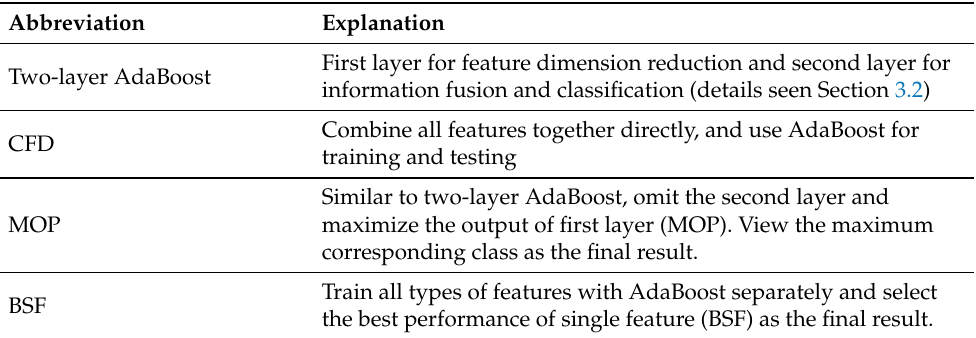
Table 7. Fusion algorithms for